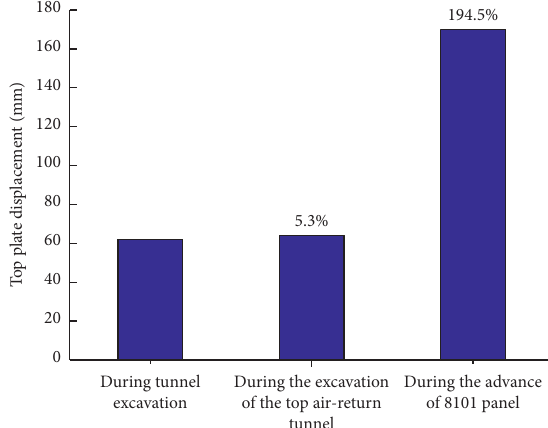
Figure 6: Comparison of peak vertical stress of the surrounding rock of air-return roadway 5103 in different mining stages.